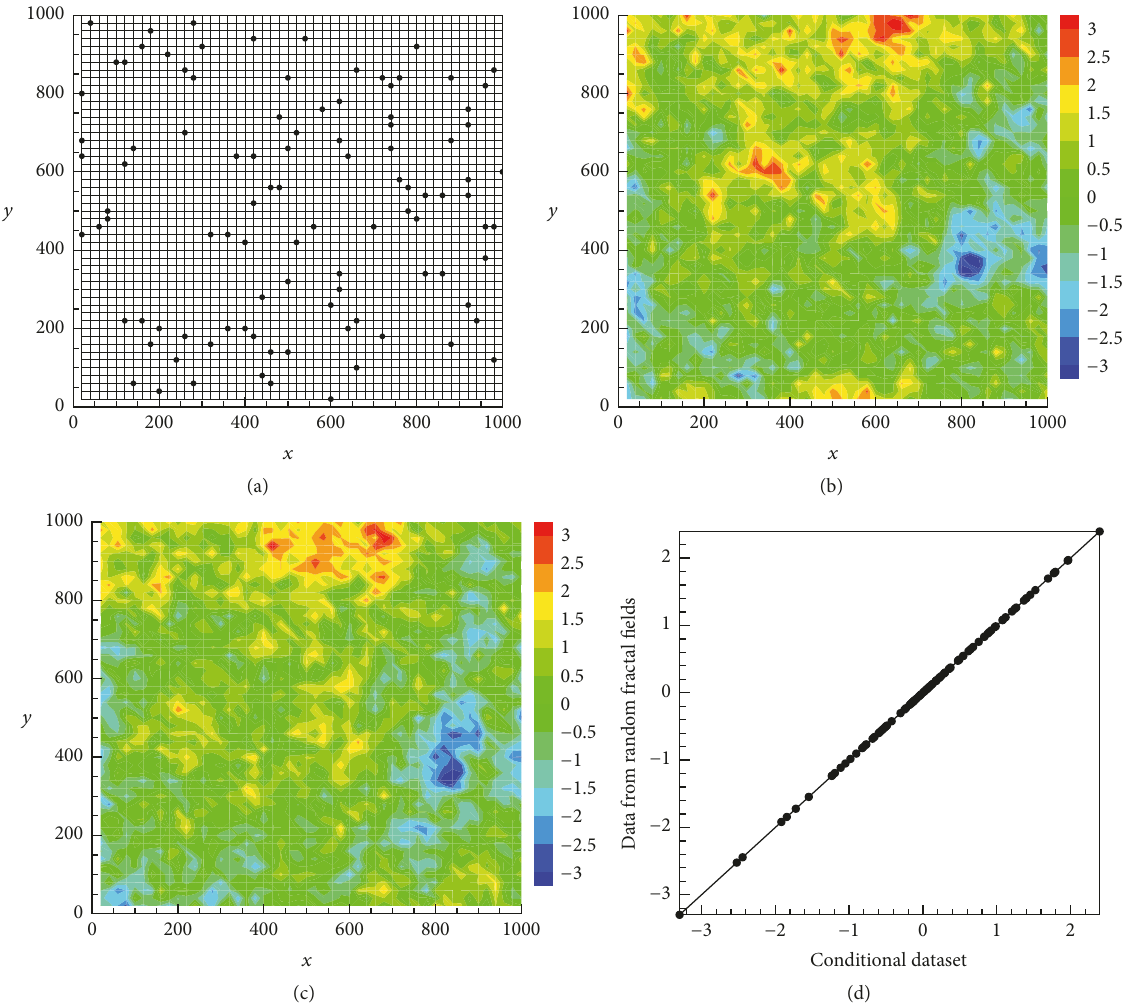
Figure 7: Conditional random fractal fields: (a) locations of the measurement data; (b) and (c) realizations of conditional random fractal fields; (d) comparison of measurements and generated values on the 100 measurement